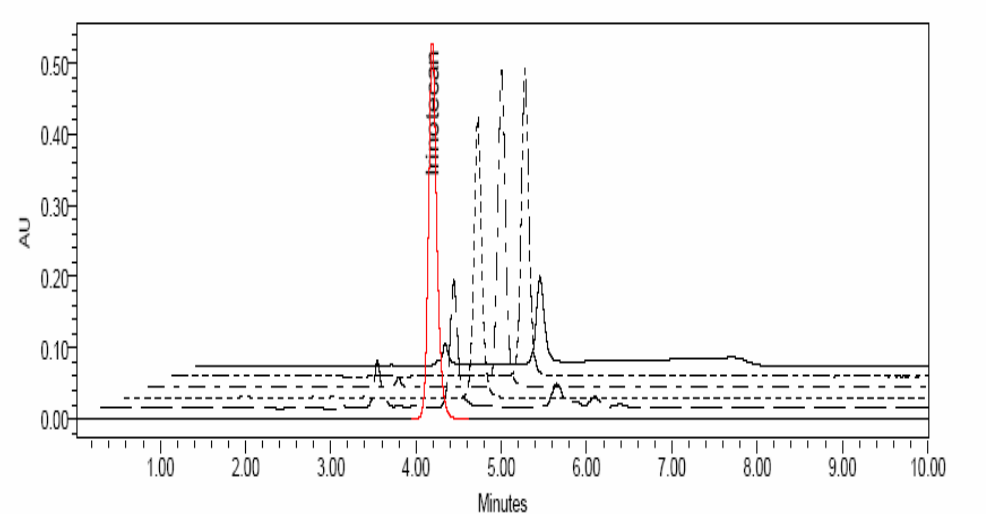
Figure 3. Chromatograms depicting the specificity of Irinotecan